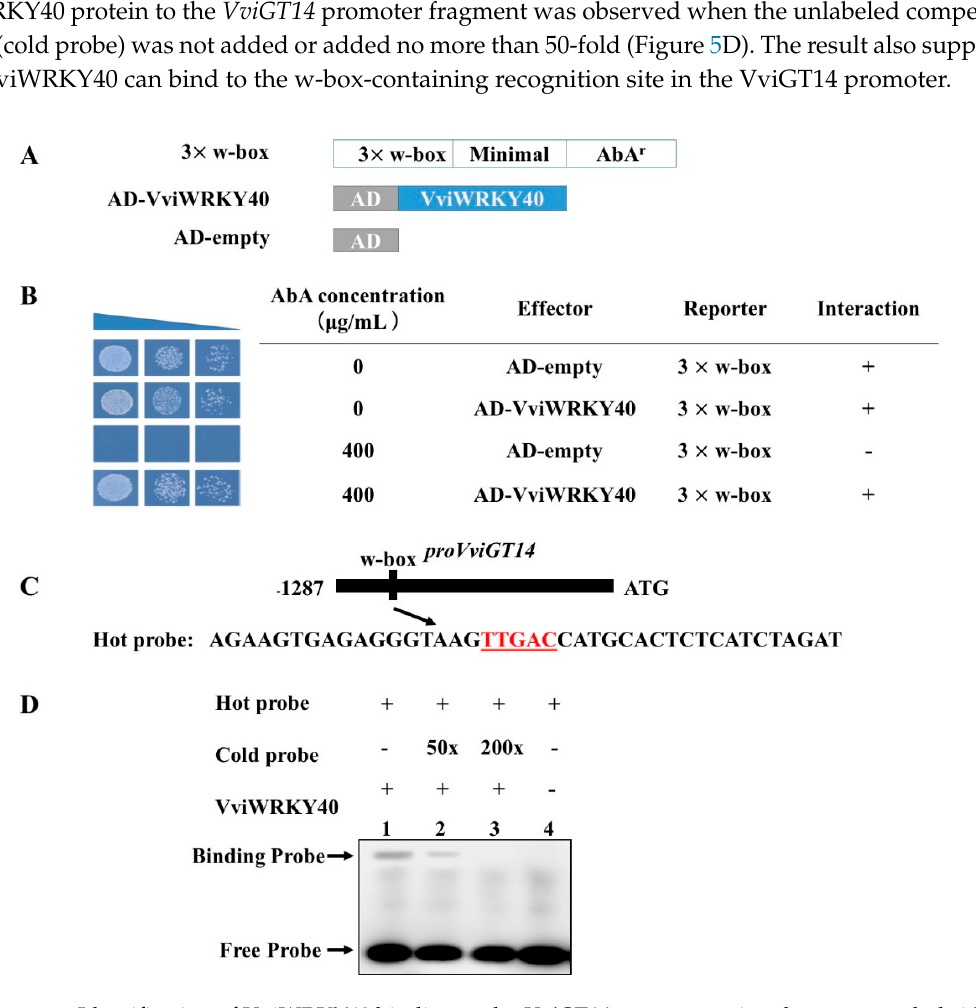
Figure 5. Identification of VviWRKY40 binding to the VviGT14 promoter using the yeast one hybrid (Y1H) ( B ) and electrophoretic mobility shift assay (EMSA) ( C ). A. The coding sequence of VviWRKY40 is introduced into the pGADT7 vector, and the three tandem w-box sequence into the pAbAi vector. B. Yeast one hybrid assay showing that yeasts carrying a combination of effector and reporter vectors can grow in the medium without or with 400 ng/mL antibiotic aureobasidin A (AbA), whereas yeasts with AD and 3× w-box could not grow on the media with 400 ng/mL AbA, indicating that the VviWRKY40 can bind with the 3 repeat w-box. C. Probes used for the EMSA. The w-box motif on the VviGT14 promoter is highlighted in red. D. EMSA showing that VviWRKY40 binds to the w-box motif of the VviGT14 promoter. The hot probe is a 3’ biotin-labledfragment of the VviGT14 promoter, while the cold probe is an unlabeled competitive probe. + and − represent the presence and absence of the VviWRKY40 or the probe, respectively, 50× and 200× indicate 50-fold and 200-fold excess of unlabeled competitive probes, respectively.